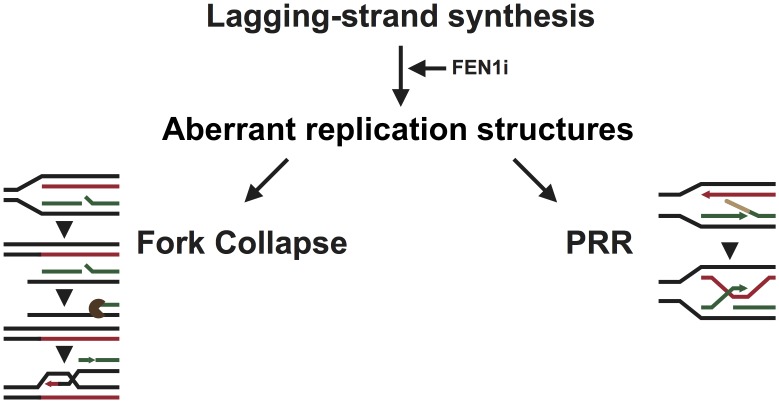
Current model for the formation and repair of DNA damage following FEN1 inhibition.The inhibition of FEN1 leads to the accumulation of immature Okazaki fragments bound by RPA, accumulating aberrant replication structures that destabilise the replication fork. The PRR machinery is thought to allow for the tolerance of such structures by switching template strand, however failure to do so in a timely manner could lead to the stalling and, ultimately, collapse of the fork. The broken fork would require processing by endonucleases to create a 3’ overhang able to invade into back into the dsDNA and re-start replication. Persistent inhibition of FEN1 would ultimately lead to an overwhelming level of DNA damage and, ultimately, cell death.